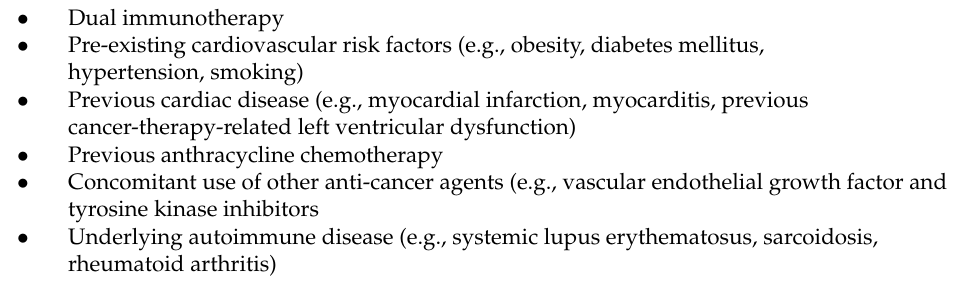
Table 1. Potential risk factors for cardiovascular adverse events in cancer patients treated with immune checkpoint